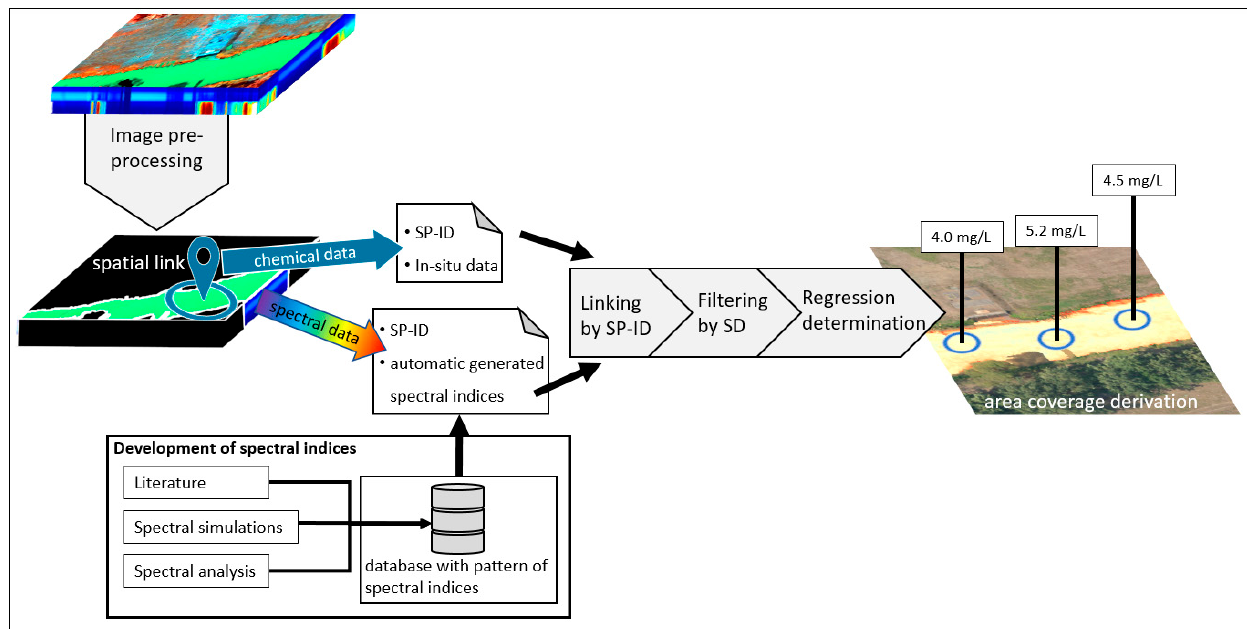
Figure 4. Flowchart of the methodical approach used to derive specific constituents of an ochre- coloured watercourse based on sampling points (SP) and airborne hyperspectral remote sensing data. Image pre-processing, development of spectral indices, data linking in two steps, data filtering using the standard deviation (SD), regression determination and derivation. Due to the two separate steps for linking the SP data with the RS data, an identi fi cation number (ID) was assigned to each SP (SP-ID).